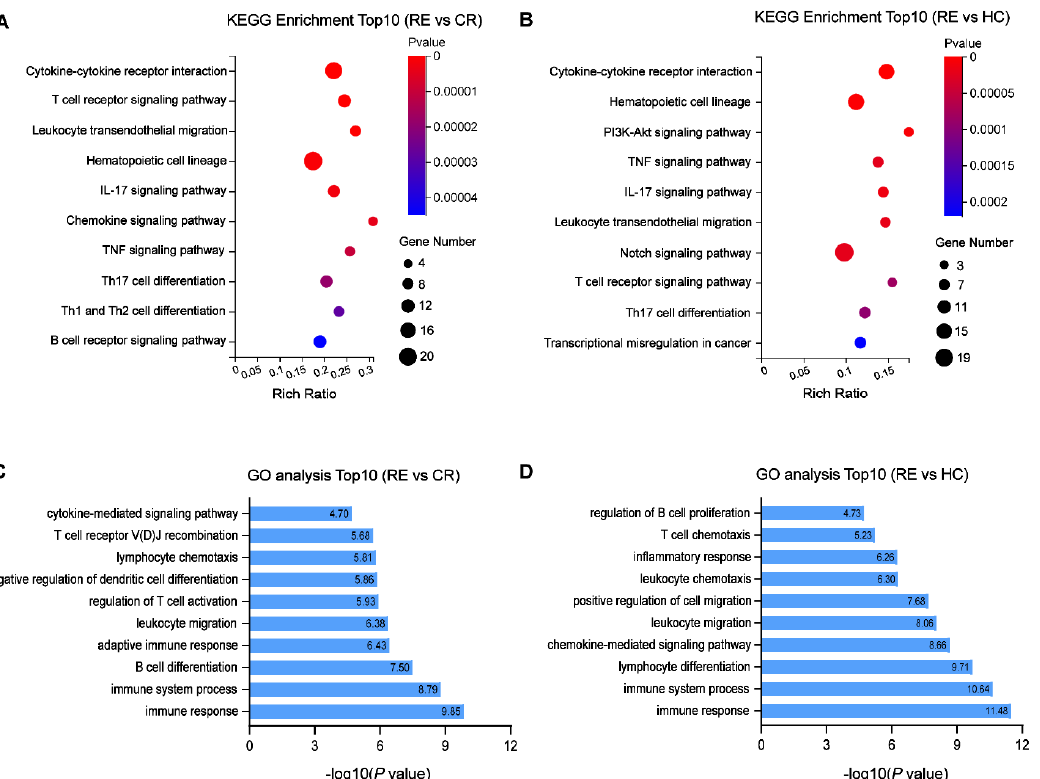
Figure 5. Functional enrichment analysis for the DE mRNAs co-expressed with identified DE circRNAs. ( A , B ) Top10 KEGG pathways enriched in AML relapse compared with remission ( A ) or healthy controls. ( B – D ) Top10 biological processes of GO terms enriched in AML relapse compared with remission ( C ) or healthy controls ( D ).